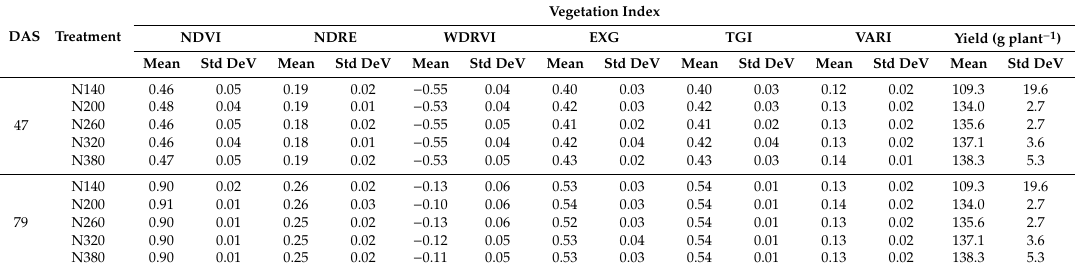
Table 3. Mean values of the vegetation indices and yield for each replicate of the treatments under di ff erent degrees of nitrogen fertilization. DAS